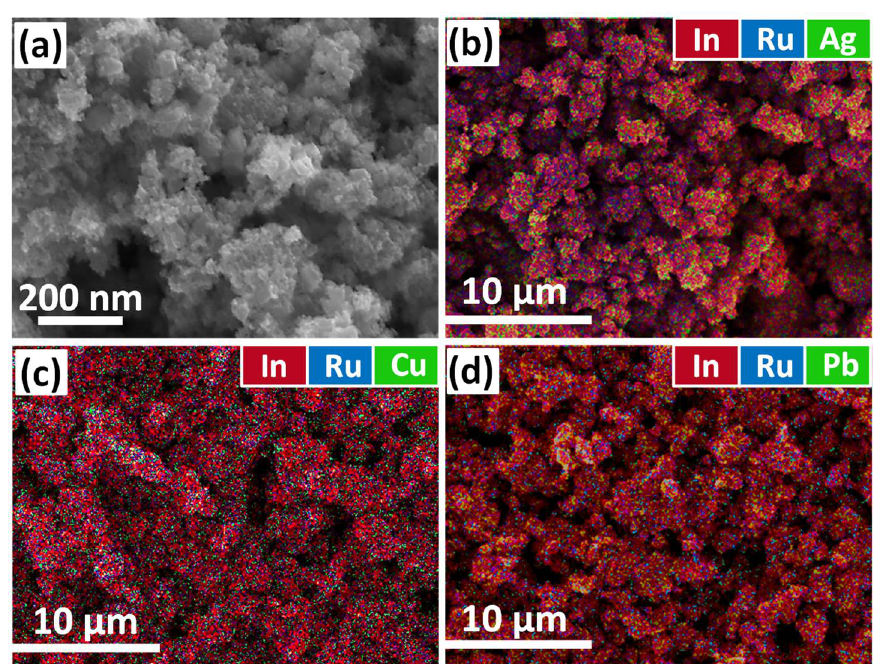
Figure 1. SEM image of the In 2 O 3 ( a ) and EDS mapping of the various elements (red—In, blue—Ru, green—second binding cation) in hybrid materials ( b – d ). green—second binding cation) in hybrid materials ( b – d ). Table 2. Assignment of FTIR spectra vibrational modes